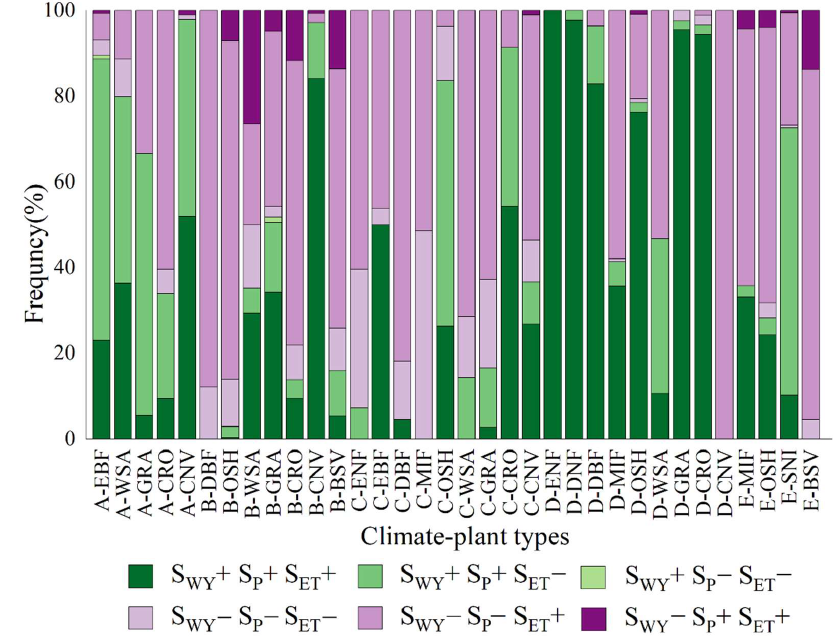
Figure 7. Composite map of the sign of terrestrial water yield (WY), precipitation (P), and evapo- transpiration (ET) trends. Colored areas indicate where WY significantly changed during 1981–2018 after correcting for multiple hypothesis testing (α = 0.05). S WY , S P , and S ET indicate the Theil–Sen’s slope of WY, P, and ET, respectively. The symbols + and − indicate a positive and negative WY (P or ET) trend during the study period, respectively.